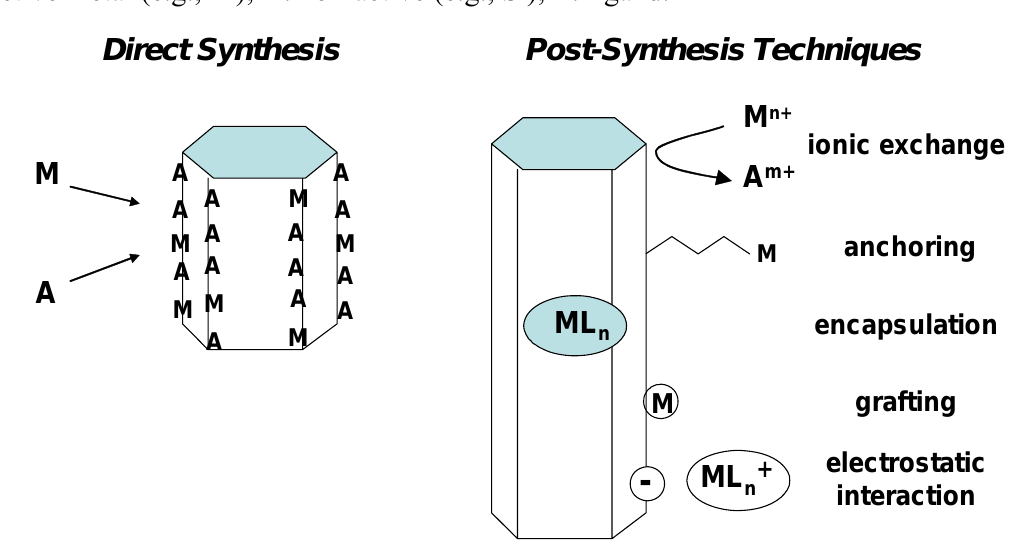
Figure 1 . Functionalization of inorganic oxide supports. Several strategies and pathways active metal (e.g., Ti); A: non-active (e.g., Si); L: